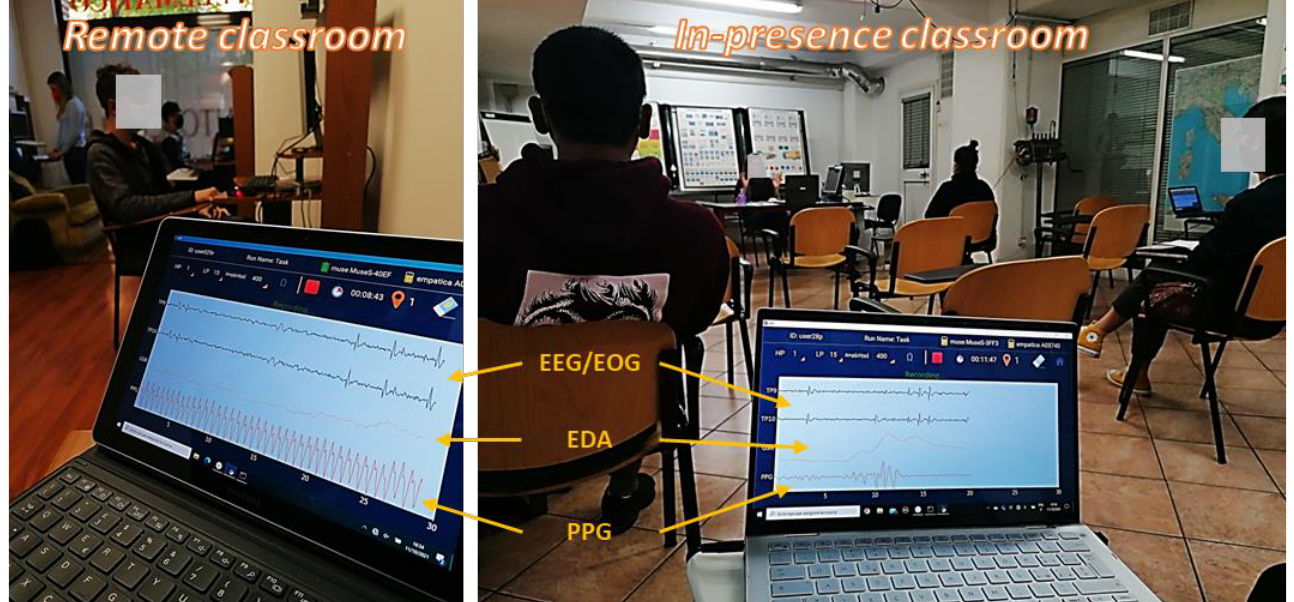
Figure 2. Two pictures of signal recording during the experimental task in both conditions (IN- PRESENCE and REMOTE). In particular, the first two blue channels are related to the EEG data gathered from Muse S, from which the EOG pattern was obtained (the blink shapes are visible). The last two orange channels are, respectively, the EDA and PPG data gathered from Empatica.